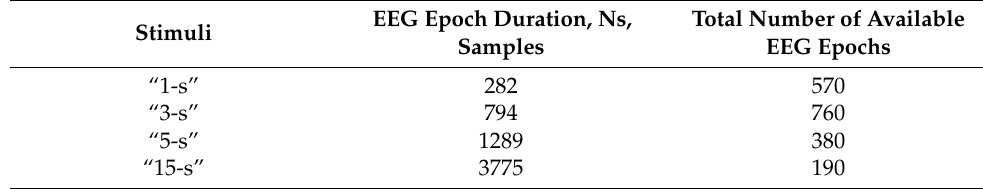
Figure 6. Distance averaged over 19 participants, 2 trials per participant, and all EEG channels as a function of stimulation color.